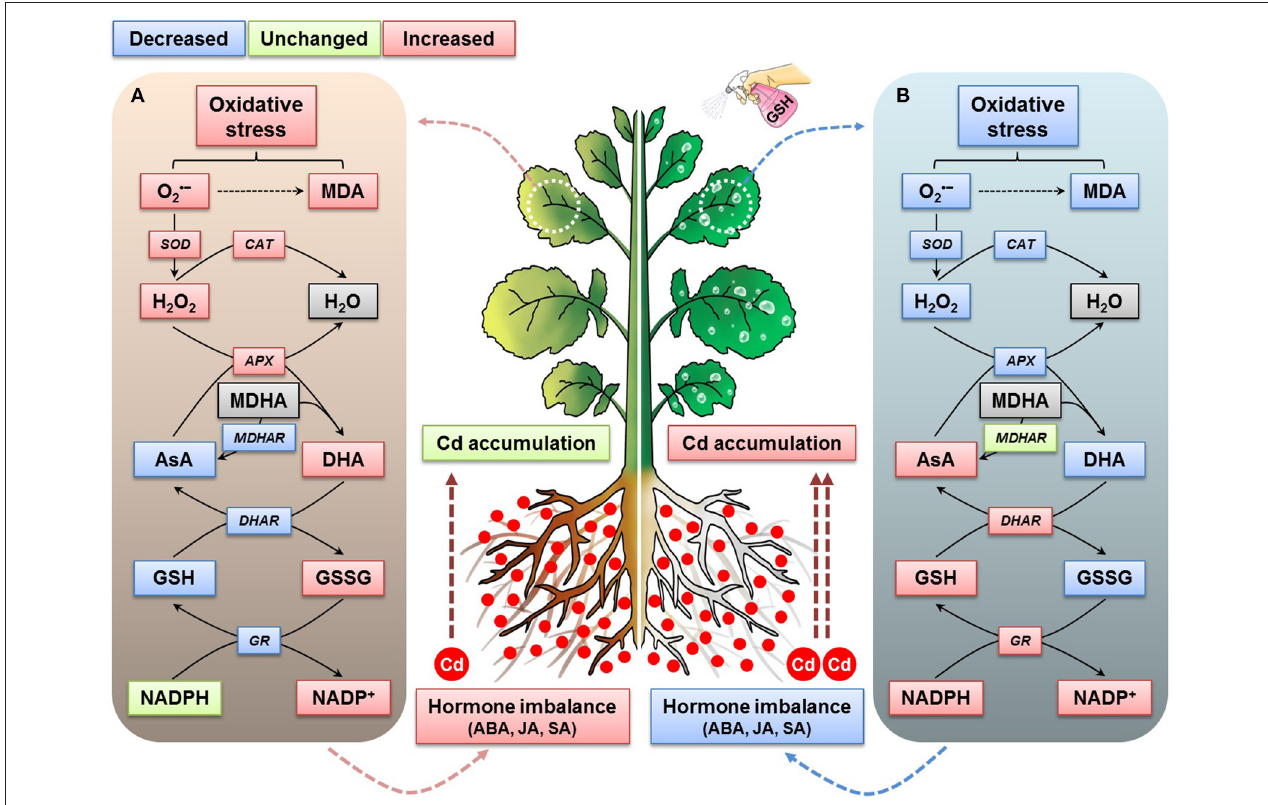
FIGURE 9 | Interconnected mechanism of the GSH-mediated modulation of Cd stress responses on ROS, redox, and stress-hormone status in oilseed rape plants. (A) Cd-stressed plant growth status and (B) Cd-stressed and GSH-treated plant growth